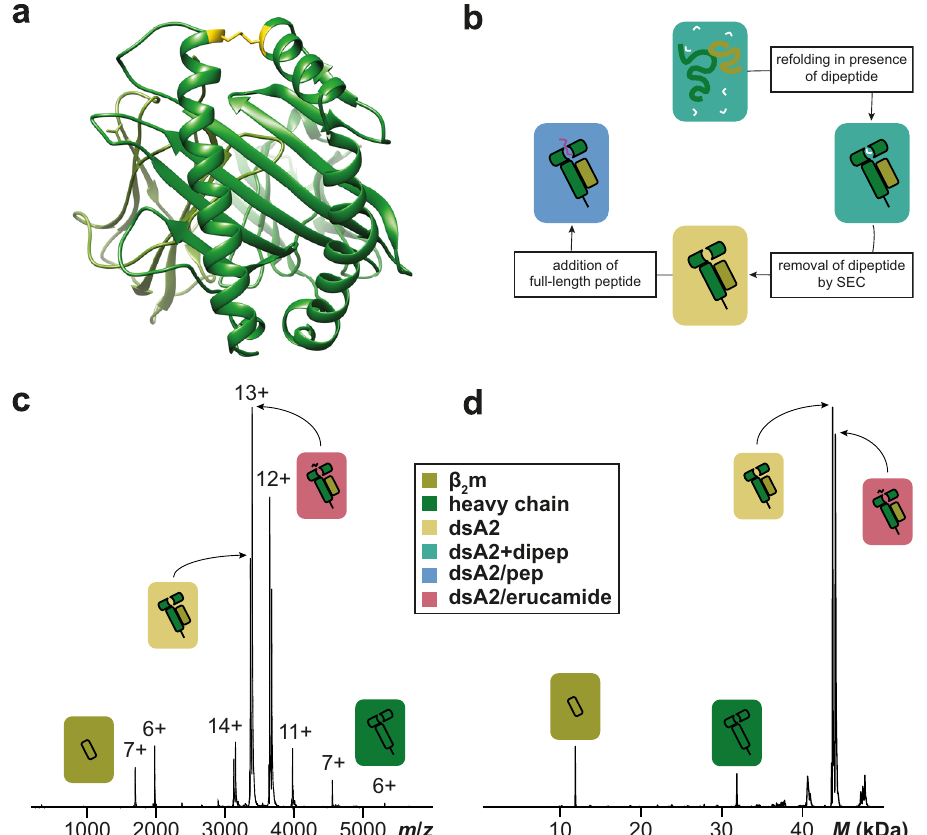
Fig. 1 Disul fi de-stabilized HLA-A*02:01. a Crystal structure of empty dsA2 (PDB 6TDR 14,68 ) seen as a top view of the peptide pocket. β 2 m is shown in olive and the heavy chain in green. The stabilizing disul fi de bond (positions 84 and 139 mutated to cysteines) is depicted in yellow. b dsA2 is refolded in presence of GM or GL dipeptide, which is then removed via size-exclusion chromatography. Afterward, full-length peptides can bind into the empty binding groove. Raw ( c ) and deconvoluted ( d ) native mass spectra of peptide-free dsA2 were recorded at an acceleration voltage of 25 V. The empty dsA2 is the predominant species (yellow). In addition, dsA2/erucamide (coral) and dissociated β 2 m (olive) and heavy chain (green) can be